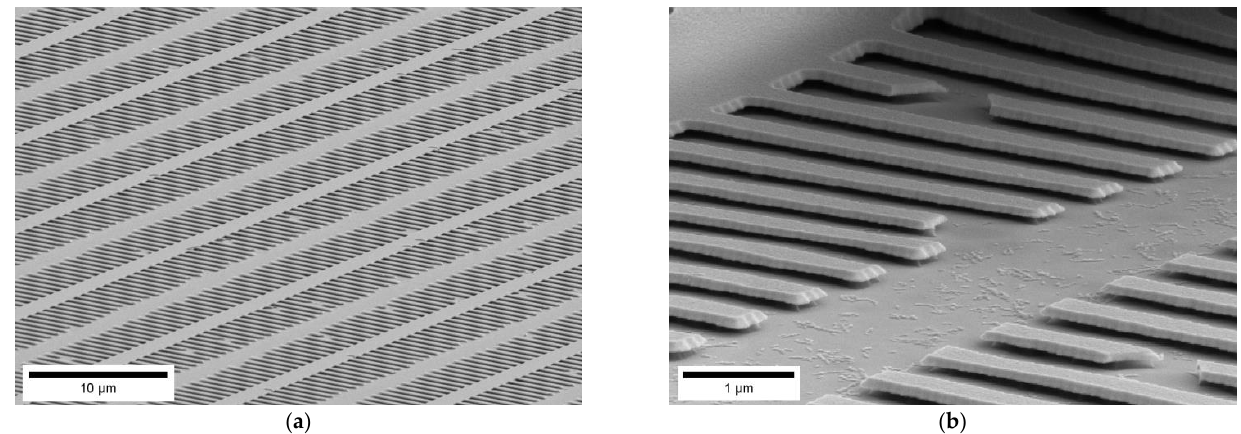
Figure 2. Defects on master after demolding from the NIL-substrate. ( a ) Overview image and ( b ) close-up of defect on master.